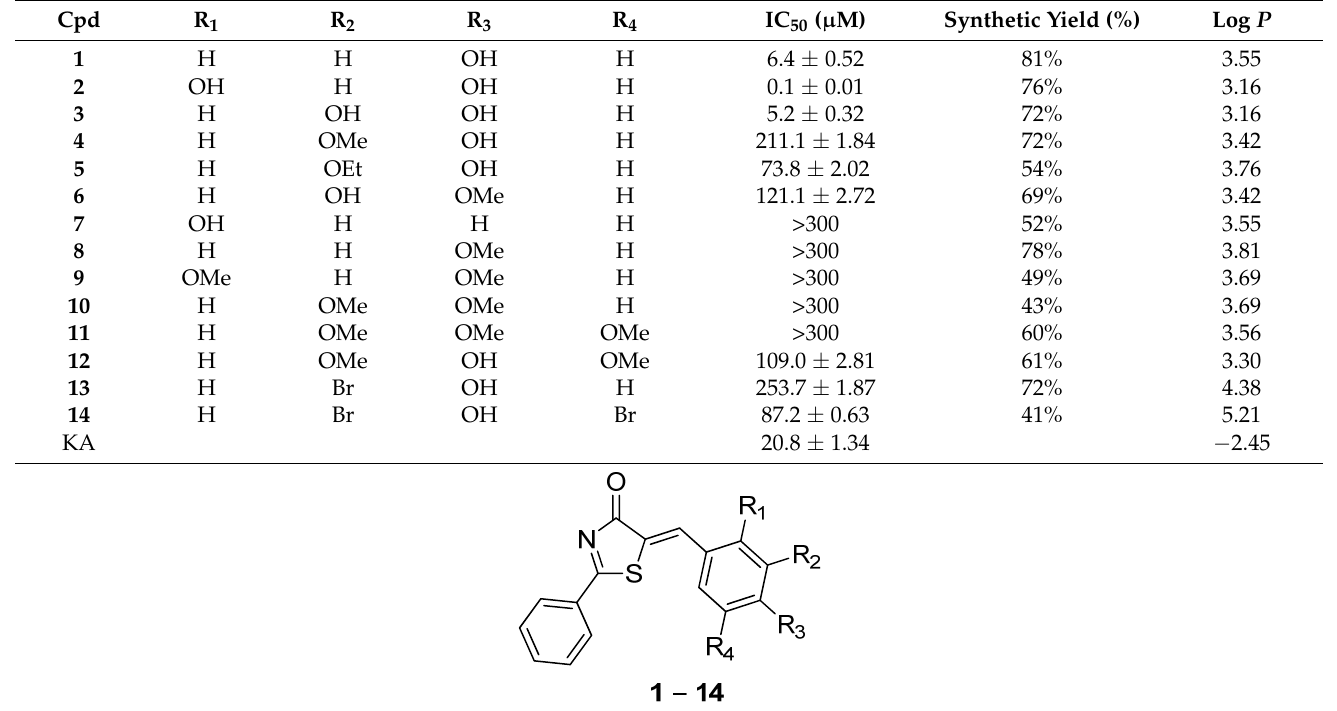
The ( Z )-BPT derivatives 8 – 11 , with no hydroxyl group, showed no potent tyrosinase the β -phenyl ring of the PUSC template, it did not exhibit mushroom tyrosinase inhibitory activity. Derivative 1 contained a 4-hydroxyl substituent on the β -phenyl ring and